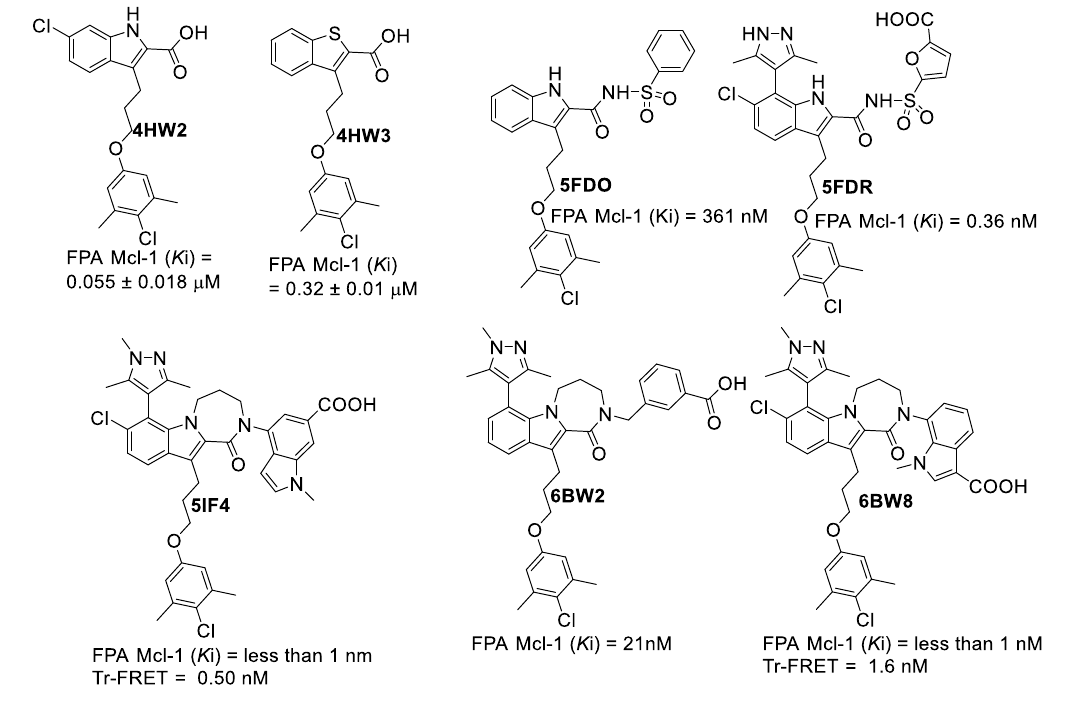
Figure 4. Fesik’s group’s ligands, which were obtained from co-crystal structures with hMcl-1 (PDB: